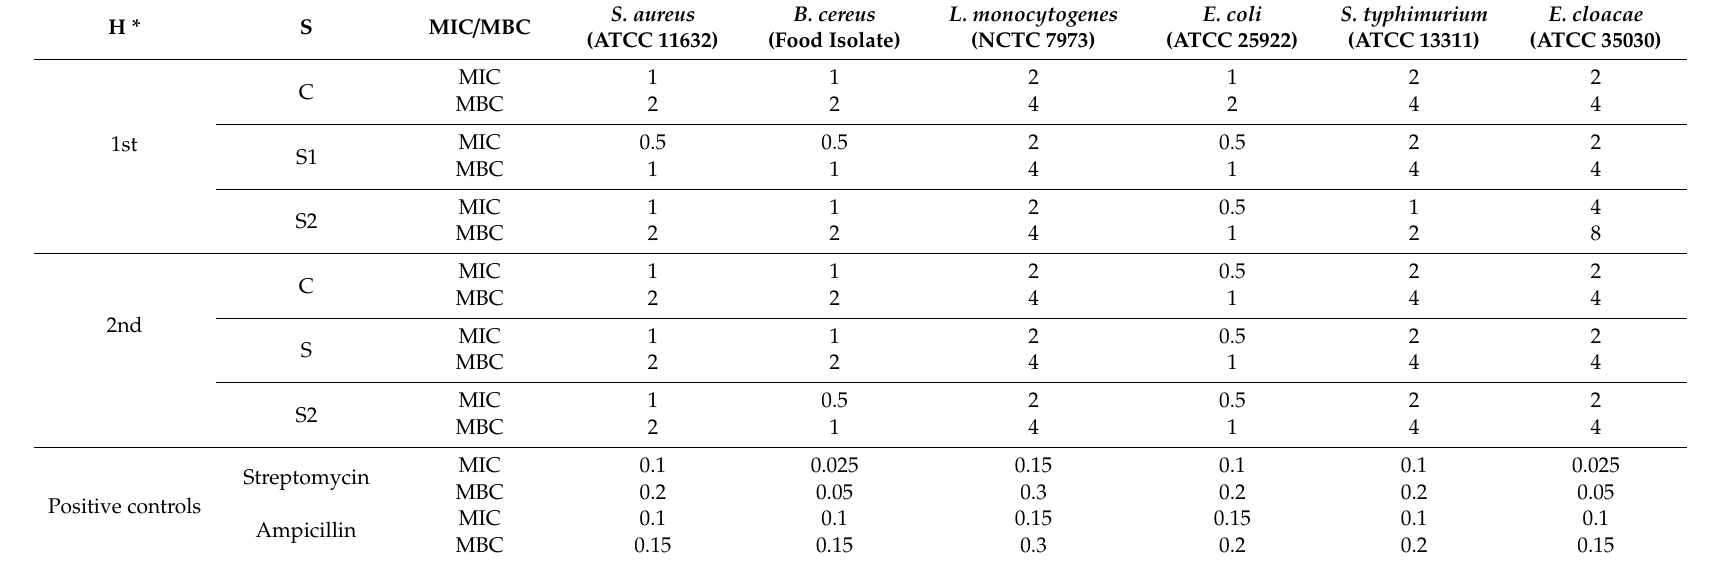
Table 11. Antibacterial activity (minimal inhibition concentration (MIC) and minimal bactericidal concentration (MBC) mg / mL) of Centaurea raphanina subsp. mixta leaves’ hydroethanolic extracts in relation to harvesting time and salinity level.